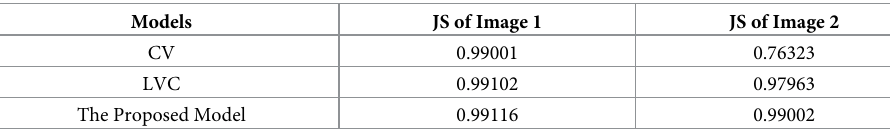
Table 2. Comparisons of Jaccard similarity coefficient of Fig